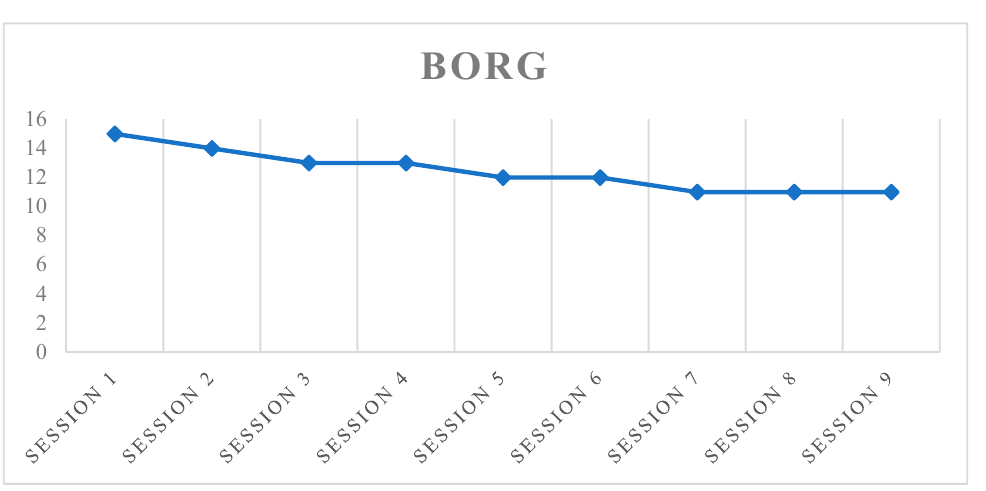
Table 3. Trend of blood pressure values.